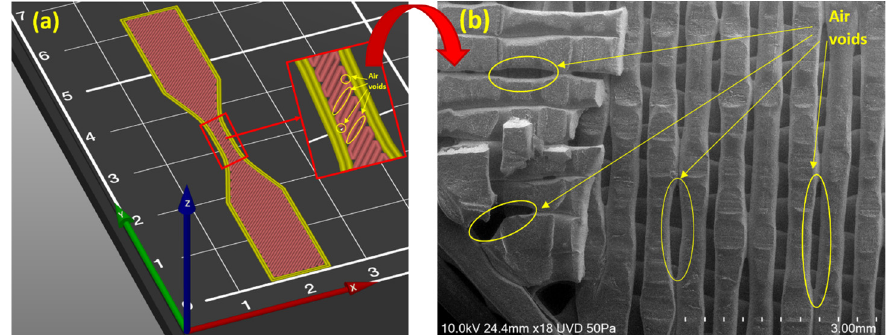
Figure 2. Void formation on samples printed by FDM: ( a ) 3D model showing the air voids; and ( b ) SEM image showing the air voids.